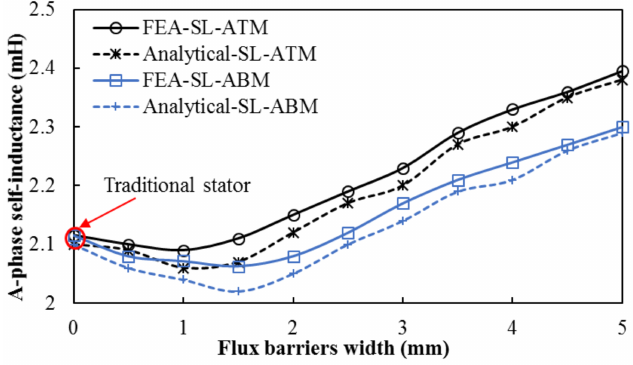
Figure 7. Variation of the A-phase self-inductance with the width of the flux barriers. It can be seen from Figure 7 that the A-phase self-inductance of both SL-ATM and SL-ABM decreases first and then increases with the increase of the width of the flux barriers. When the decrease of air-gap inductance is greater than the increase of slot leakage inductance and tooth tip leakage inductance, the overall inductance of the machine shows a downward trend. When the decrease of air-gap inductance is less than the increase of slot leakage inductance and tooth tip leakage inductance, the overall inductance of the machine shows an upward